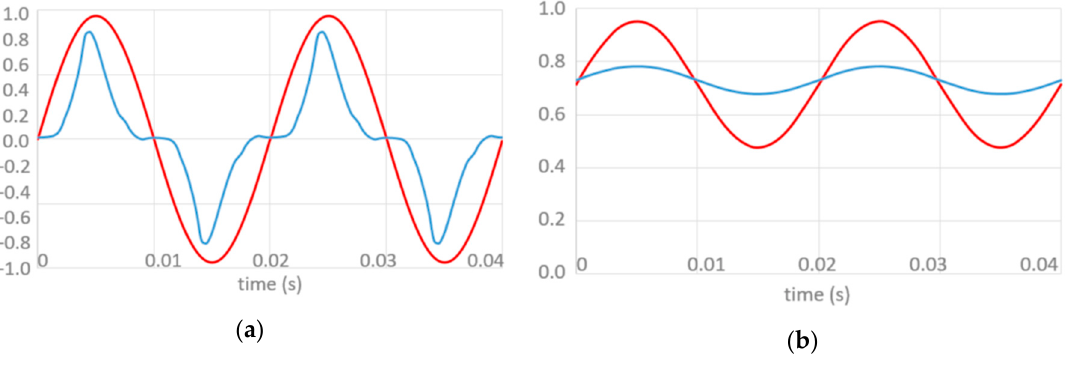
Figure 5. Simulation of the current I ac drawn by the LED lamp ( a ), and the output LED load current I LED ( b ). The blue represents the case when the storage capacitor is directly connected on the low frequency side and the red on the high frequency side.